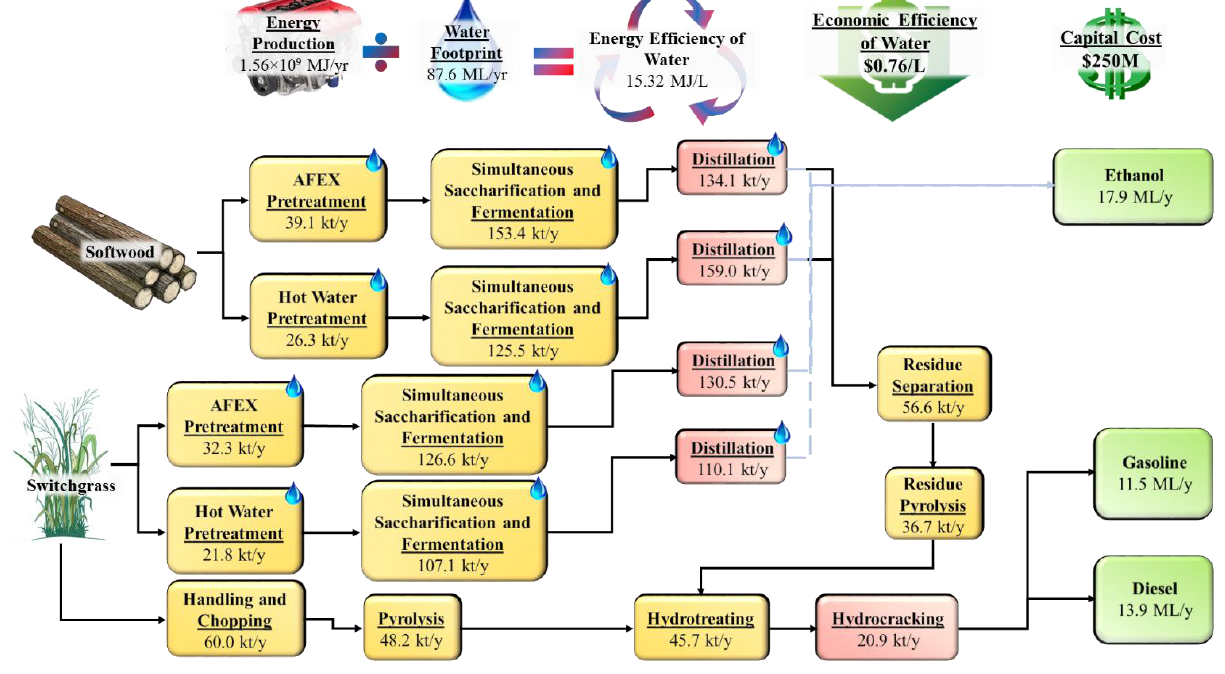
Figure 5. Optimal processing pathway, water footprint, economic efficiency of water, overall capital cost, and energy efficiency of water of the maximum economic efficiency of water